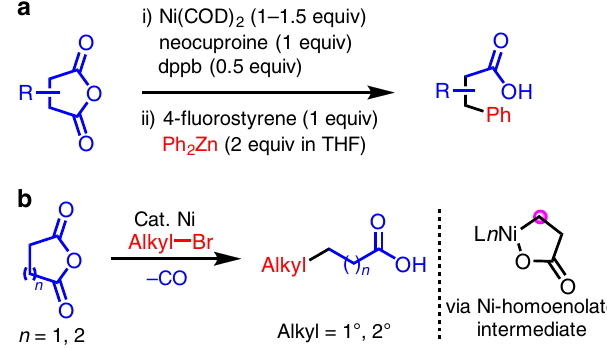
Fig. 2 Nickel-mediated functionalization of cyclic anhydrides. a Rovis ’ s stoichiometric nickel complex with Ph 2 Zn. b This work: Ni-catalyzed functionalization with alkyl